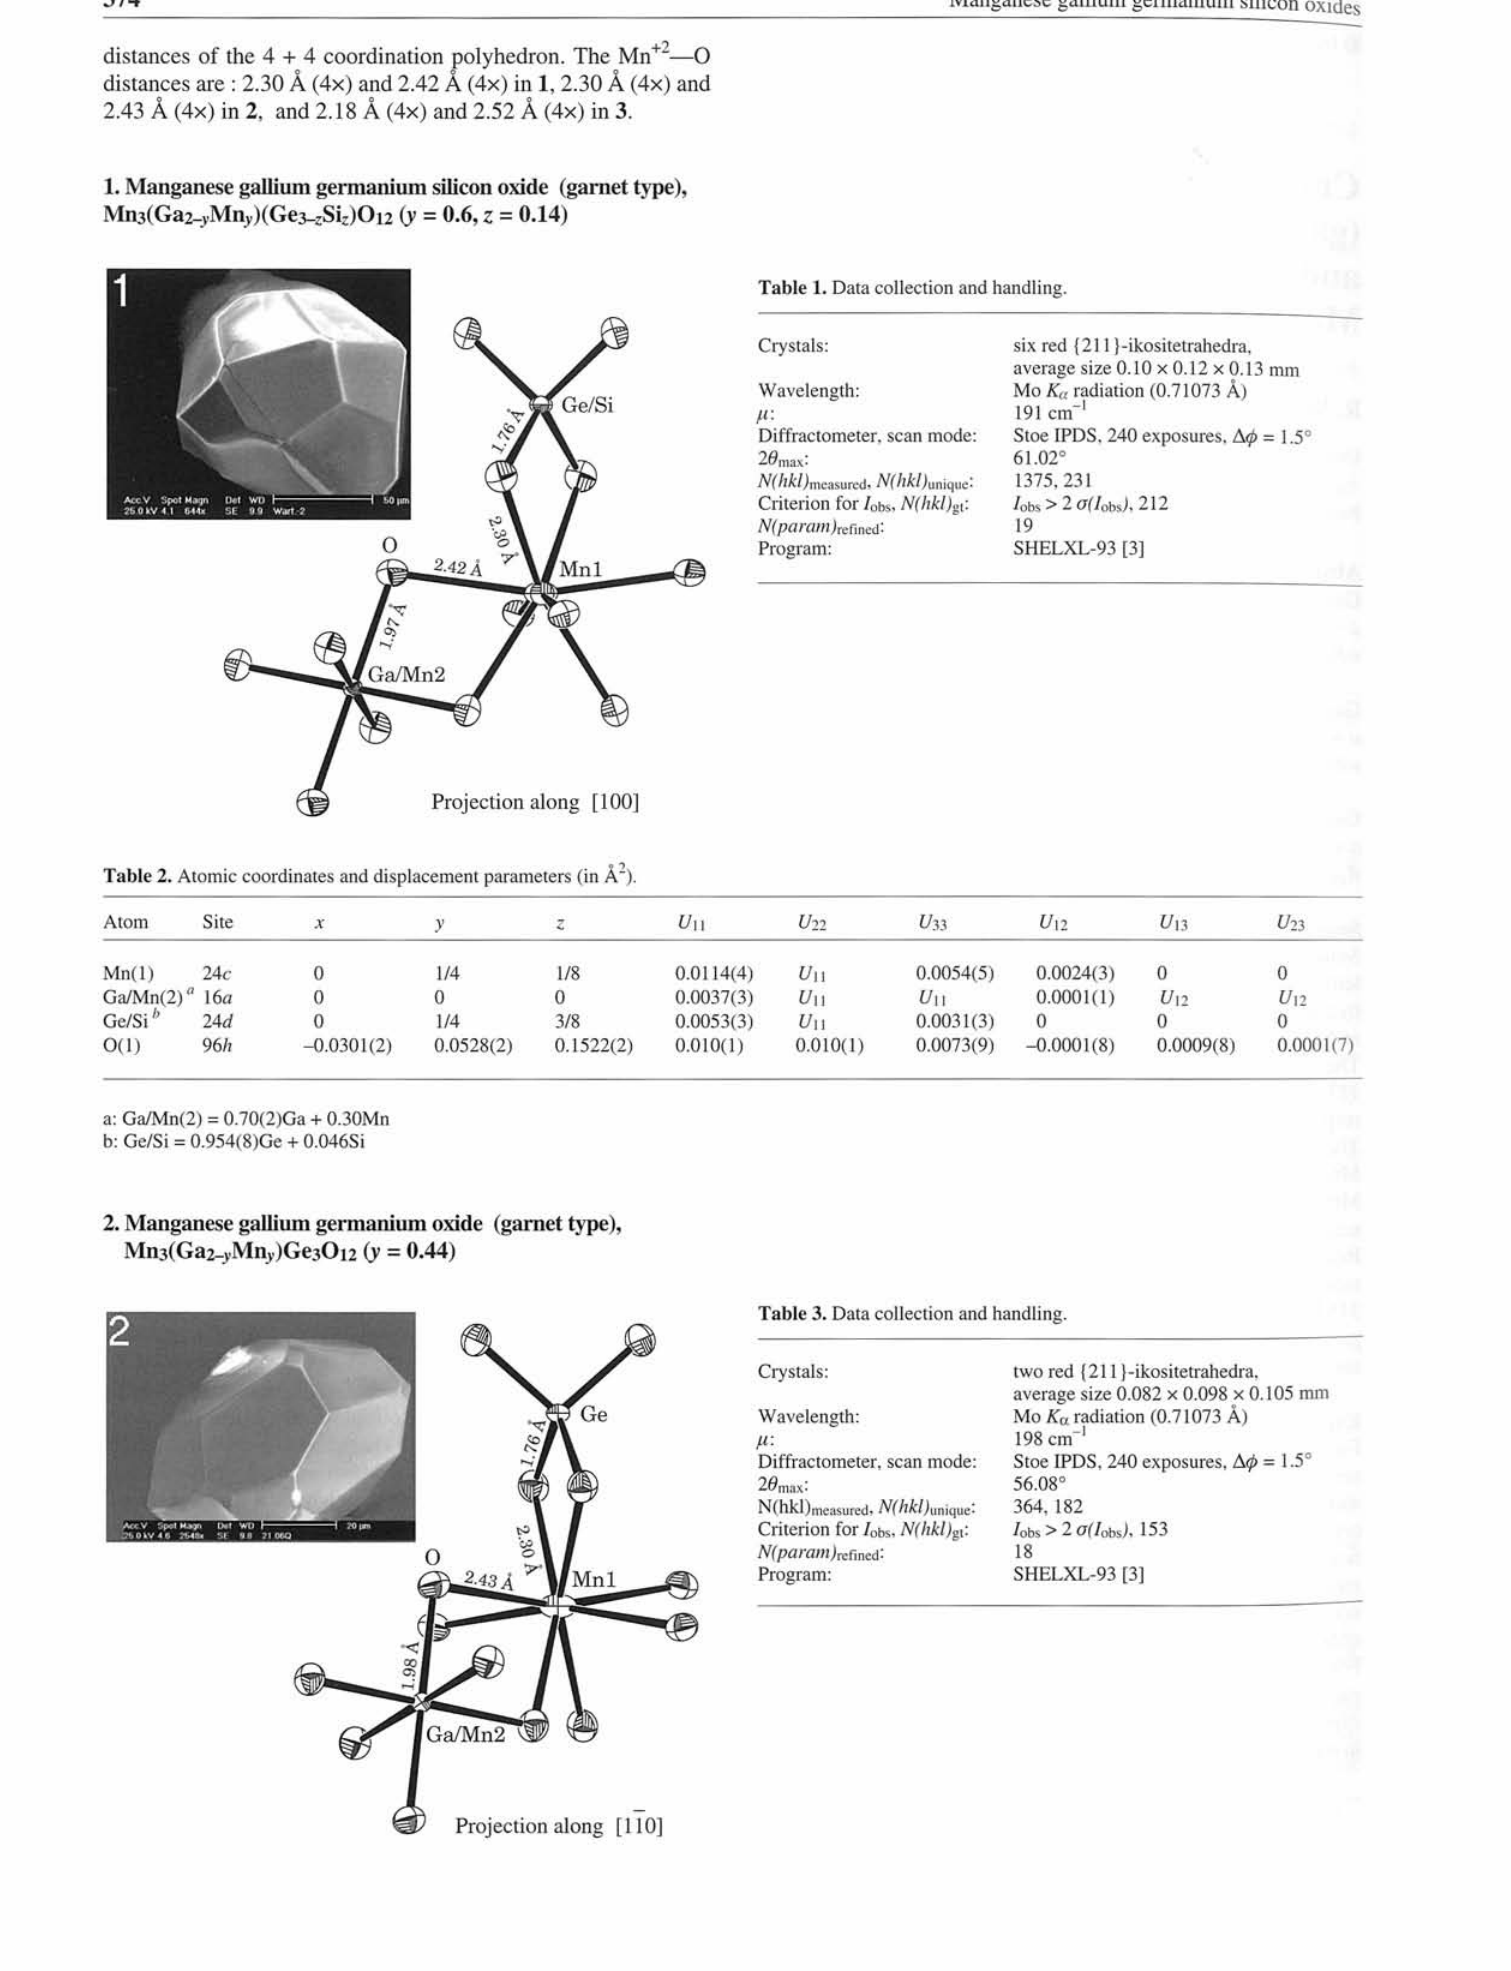
Table 1. Data collection and handling.